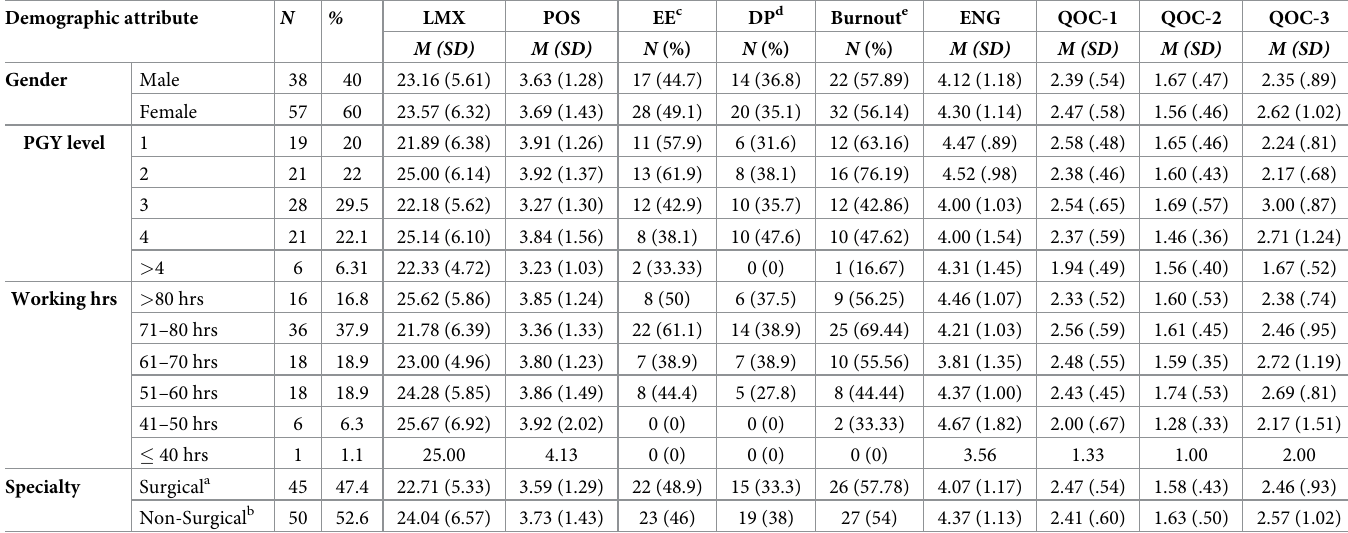
Table 1. Descriptive statistics for study constructs by demographic characteristics. Demographic